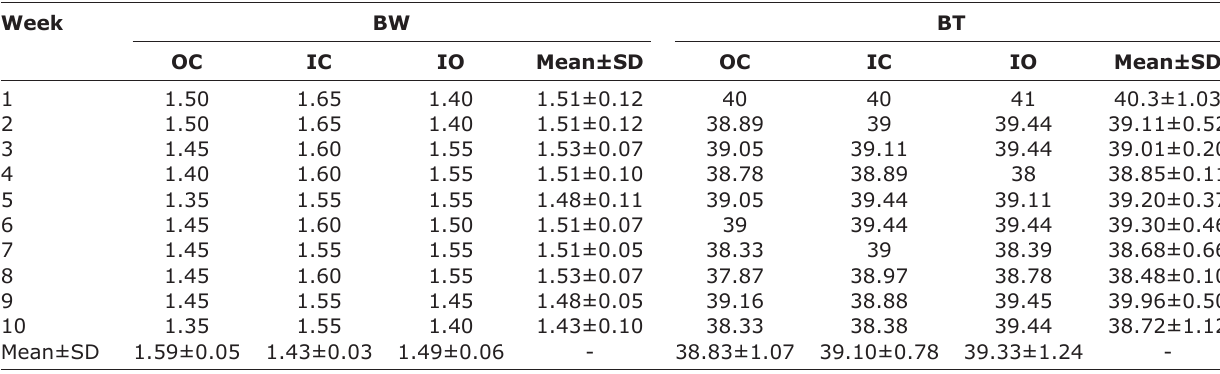
Table-1: BT (°C) and BW (kg) of Angora rabbits under control condition. Week